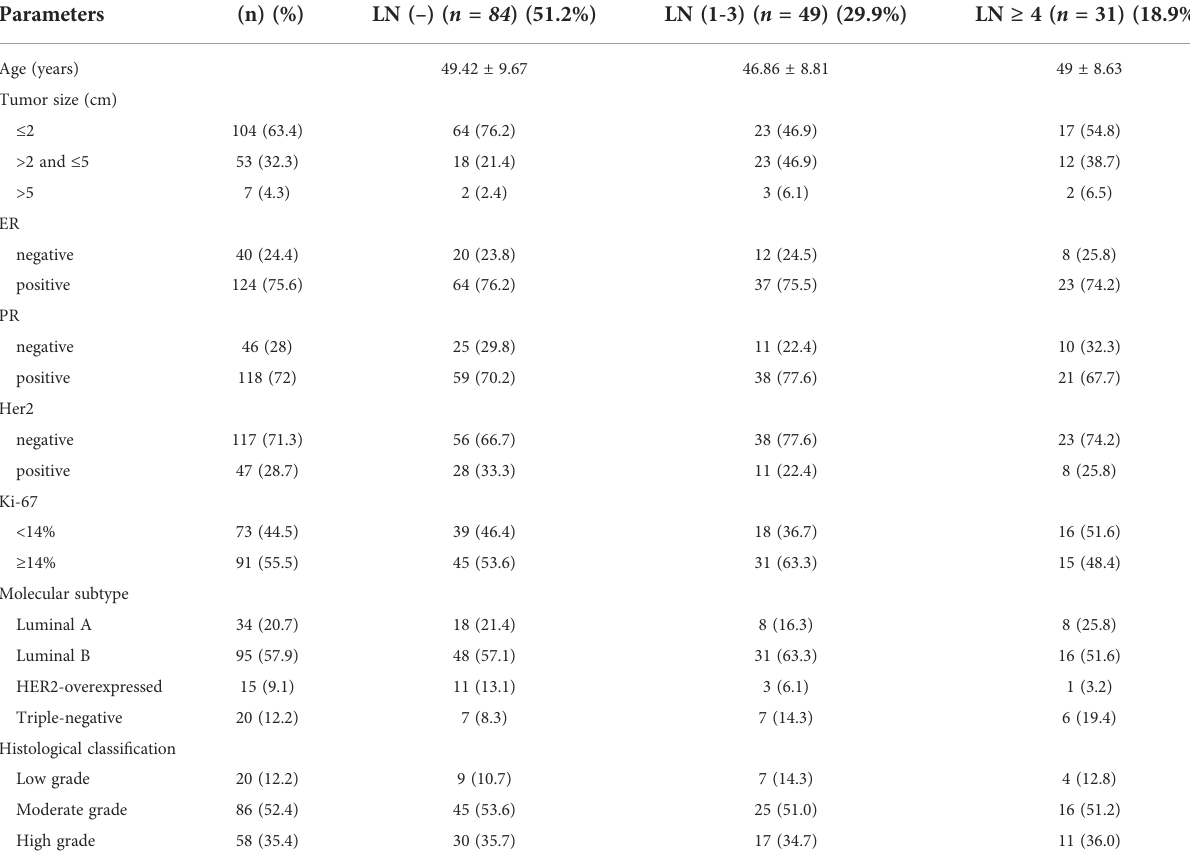
TABLE 1 Clinical characteristics of 164 patients with breast cancer included in this